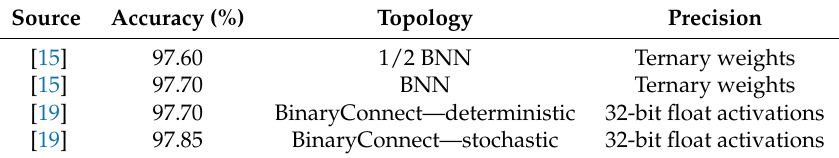
Table 8. Accuracies on the SVHN dataset of non-binary networks related to works reviewed.